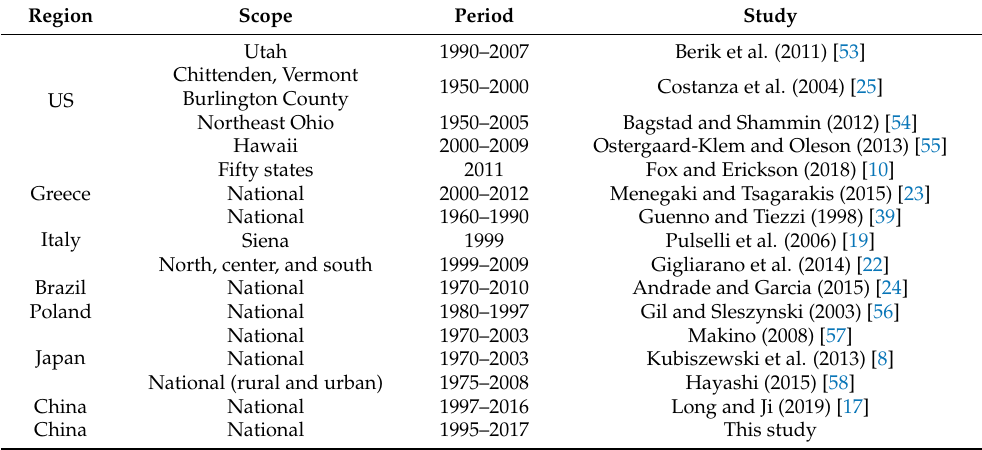
Table 3. A summary of previous studies that have not found any sign of the threshold effect.